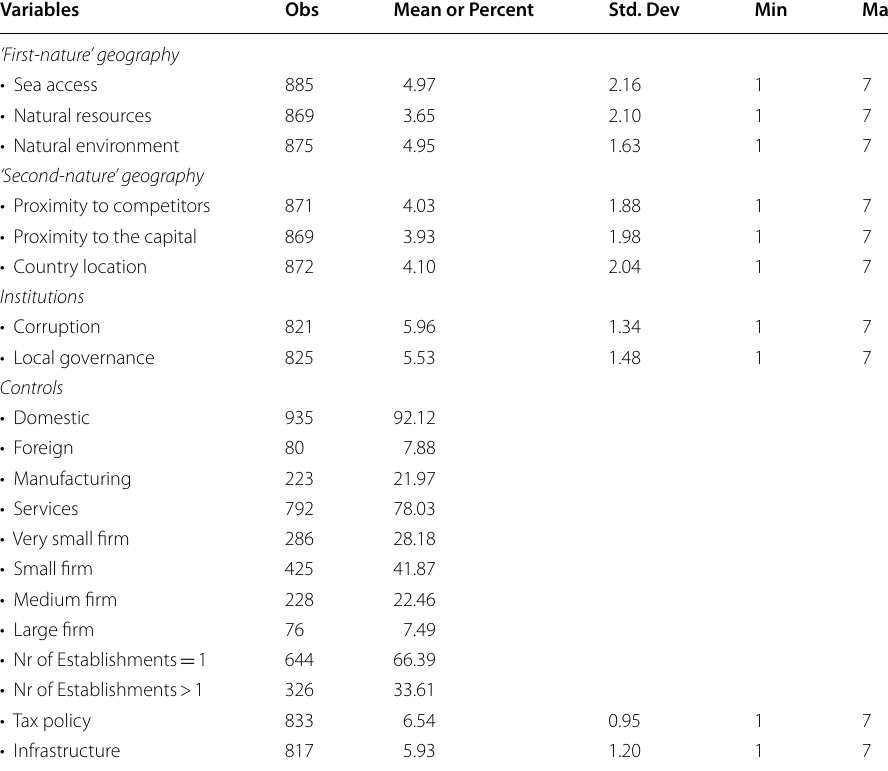
Table 2 Descriptive statistics Variables Obs Mean or Percent Std. Dev Min Max ‘First-nature’ geography